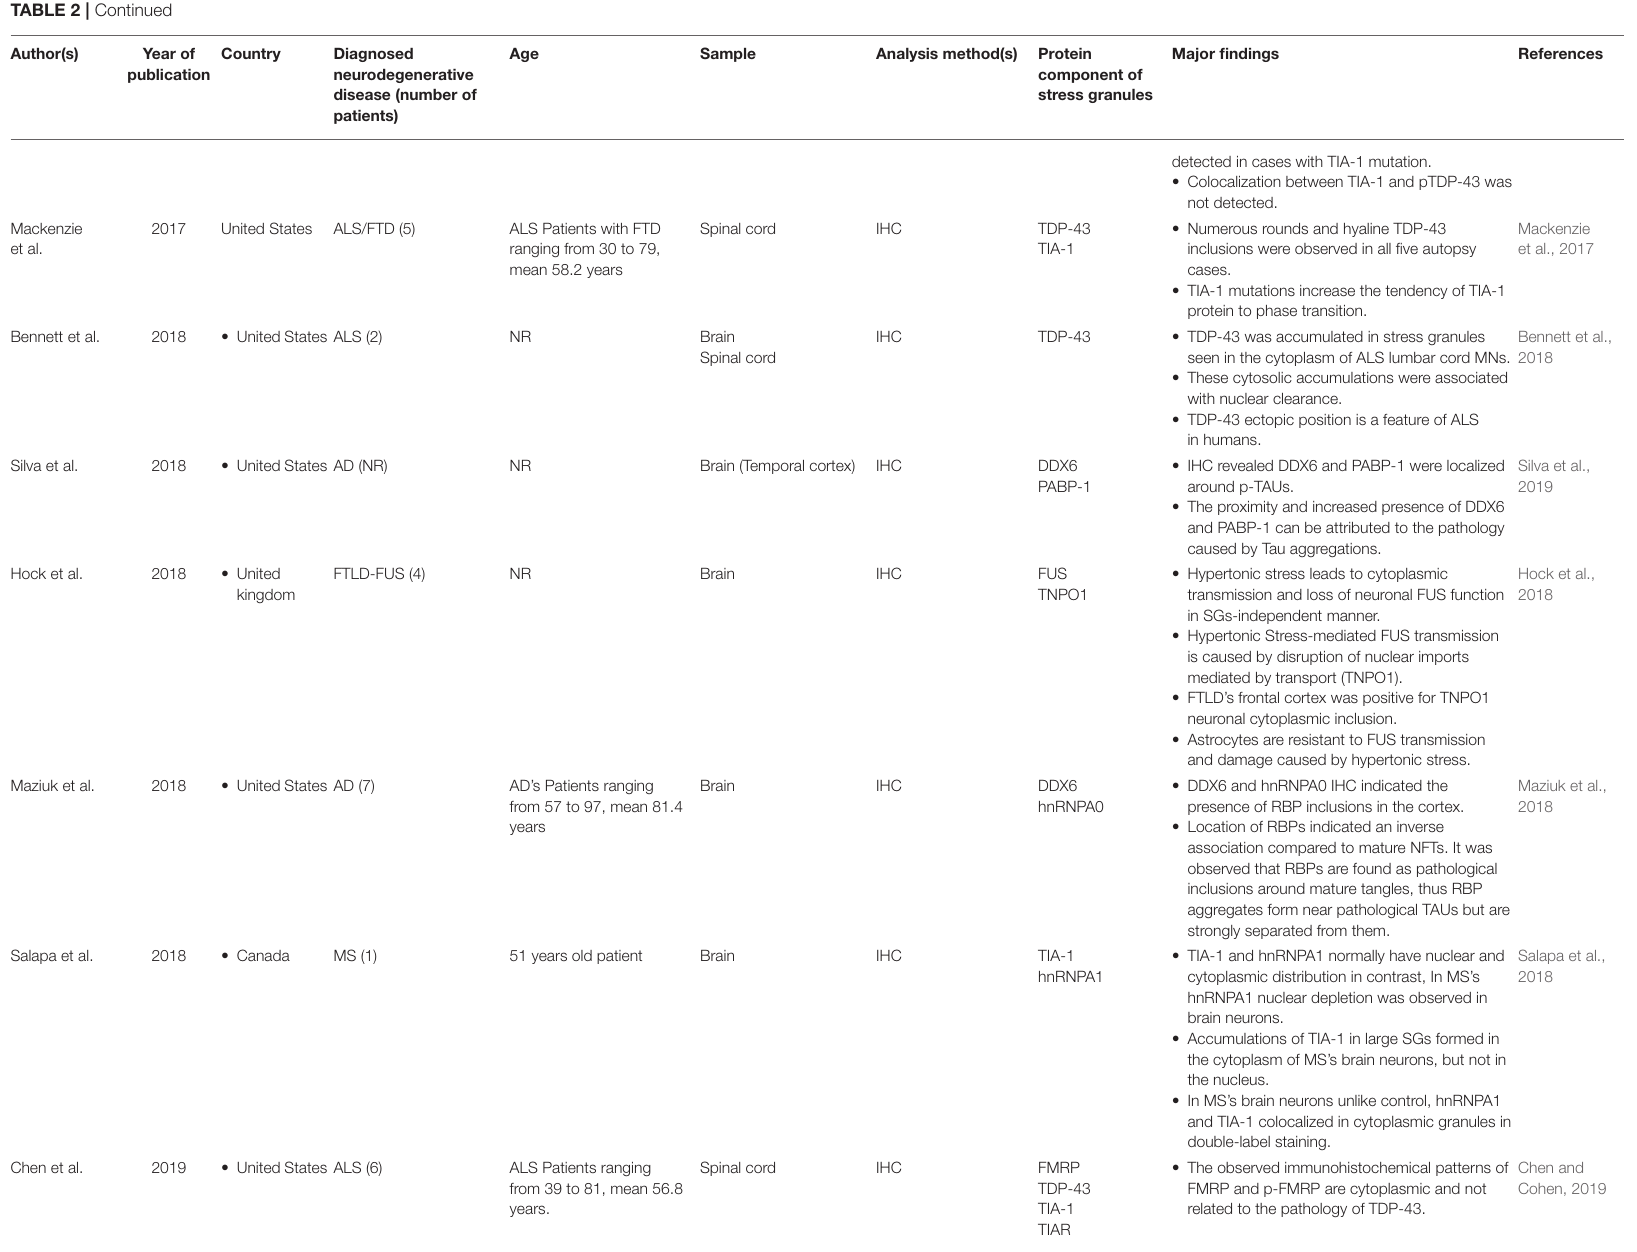
detected in cases with TIA-1 mutation. • Colocalization between TIA-1 and pTDP-43 was not